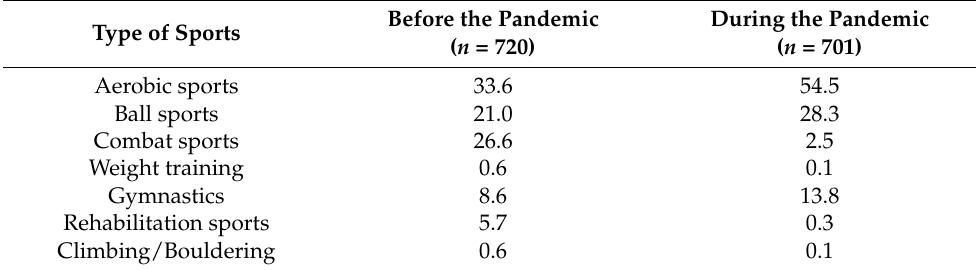
Table 1. Frequencies (%) of type of sports mentioned before and during the pandemic. Before the Pandemic Type of Sports ( n =